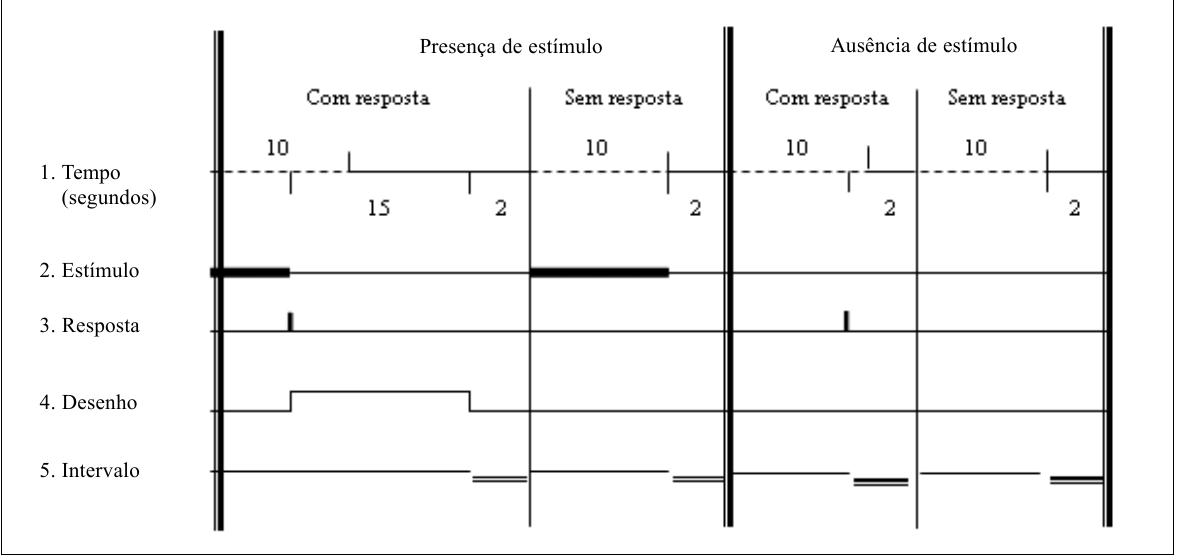
Figura 1 . Diagrama das condições experimentais empregadas no procedimento Nota . Nas linhas estão representados os eventos: o tempo em segundos (linha 1); a apresentação dos estímulos auditivos como linha cheia grossa (linha 2); a emissão de resposta indicada por uma marca vertical (linha 3); a duração da apresentação da conseqüência (desenho animado) indicada pelo deslocamento da linha para acima (linha 4); e o intervalo entre tentativas, repre- sentado pela linha dupla, deslocada para baixo. As colunas apresentam amostras de segmentos do procedimento na Presença e na Ausência do estímulo, com ou sem ocorrência da